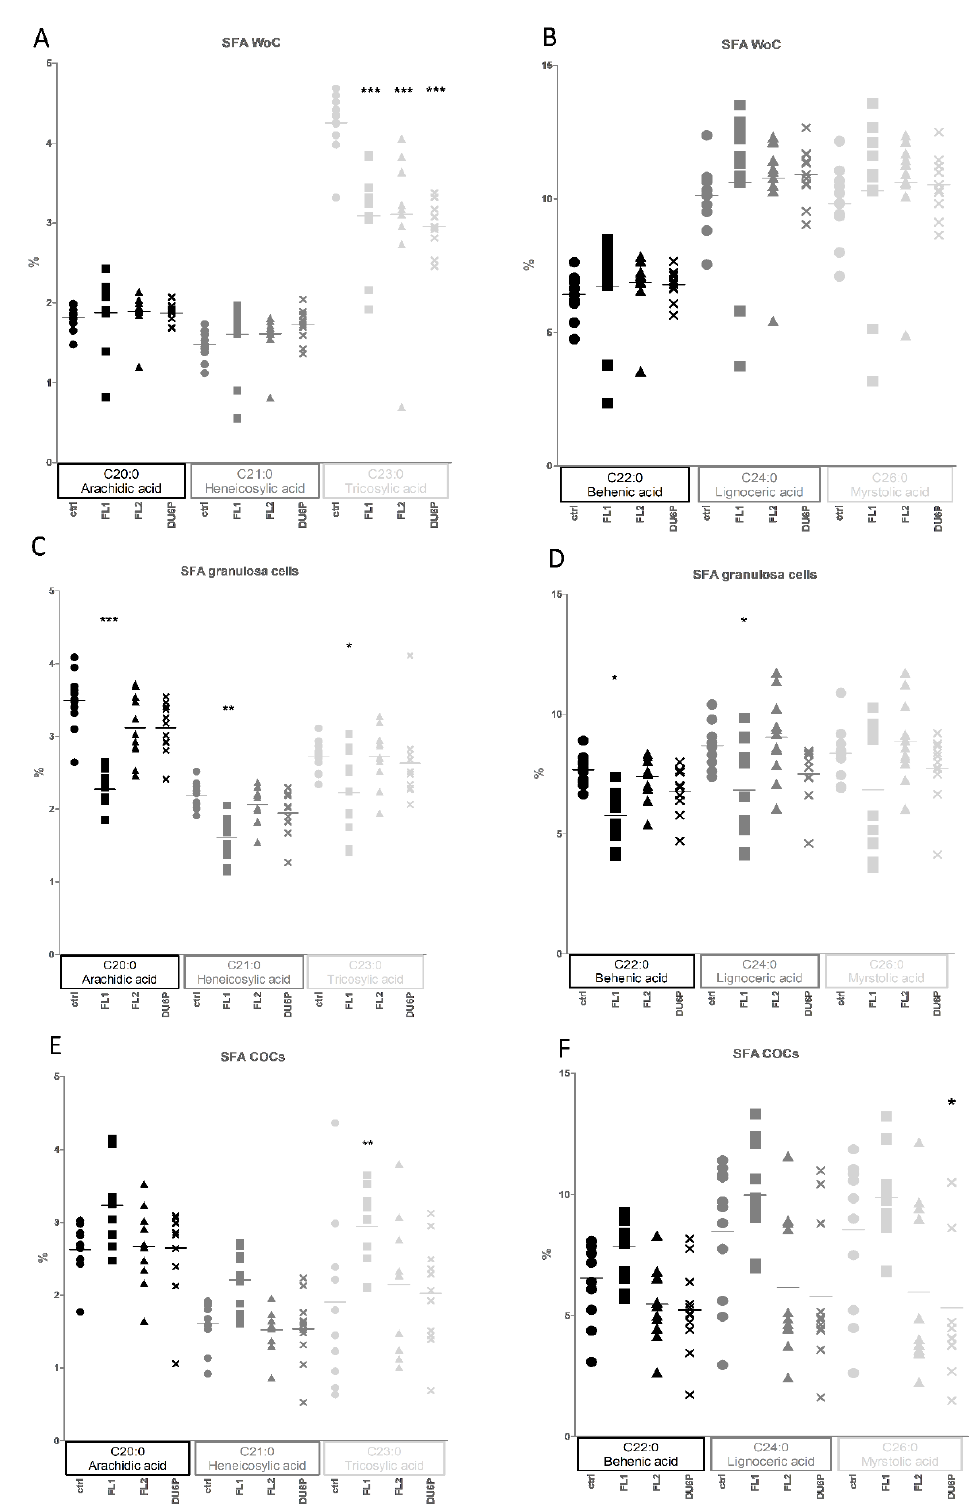
Figure 10. Percentages of the most abundant SFAs in oocytes without cumulus ( A , B ), granulosa cells ( C , D ) and COCs ( E , F ), in control (circles), FL1 (squares), FL2 (triangles) and DU6P (crosses). Different FAs are represented using different dimensions and tonalities. Data are illustrated as the mean ± SEM (standard error of the mean) and designated significant if p < 0.05 (Bonferroni posttest: * p < 0.05; ** p < 0.01; *** p < 0.005, in comparison with control of the same group).